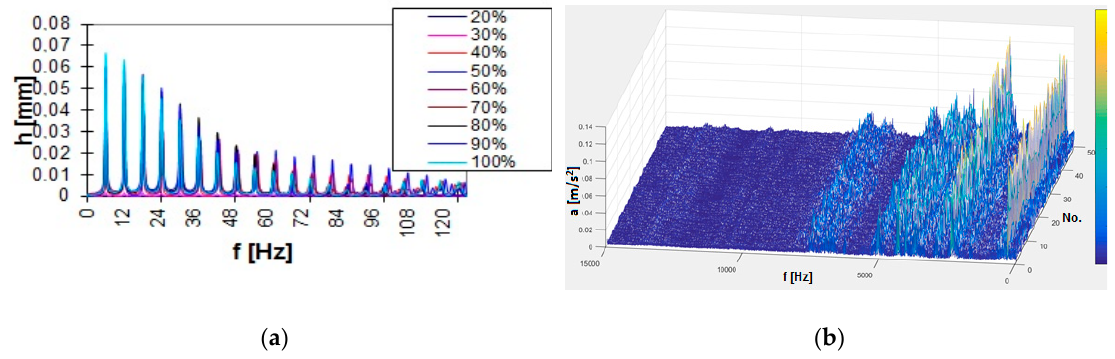
Figure 5. Influence of the fuel setting in the range of 20–100% on the spectrum of displacement vibration signals in the 0–125 Hz frequency band ( a ); the cascade spectrum of the vibration acceleration signal in the injection subsystem in the 0–15 kHz frequency band ( b ): f —frequency.